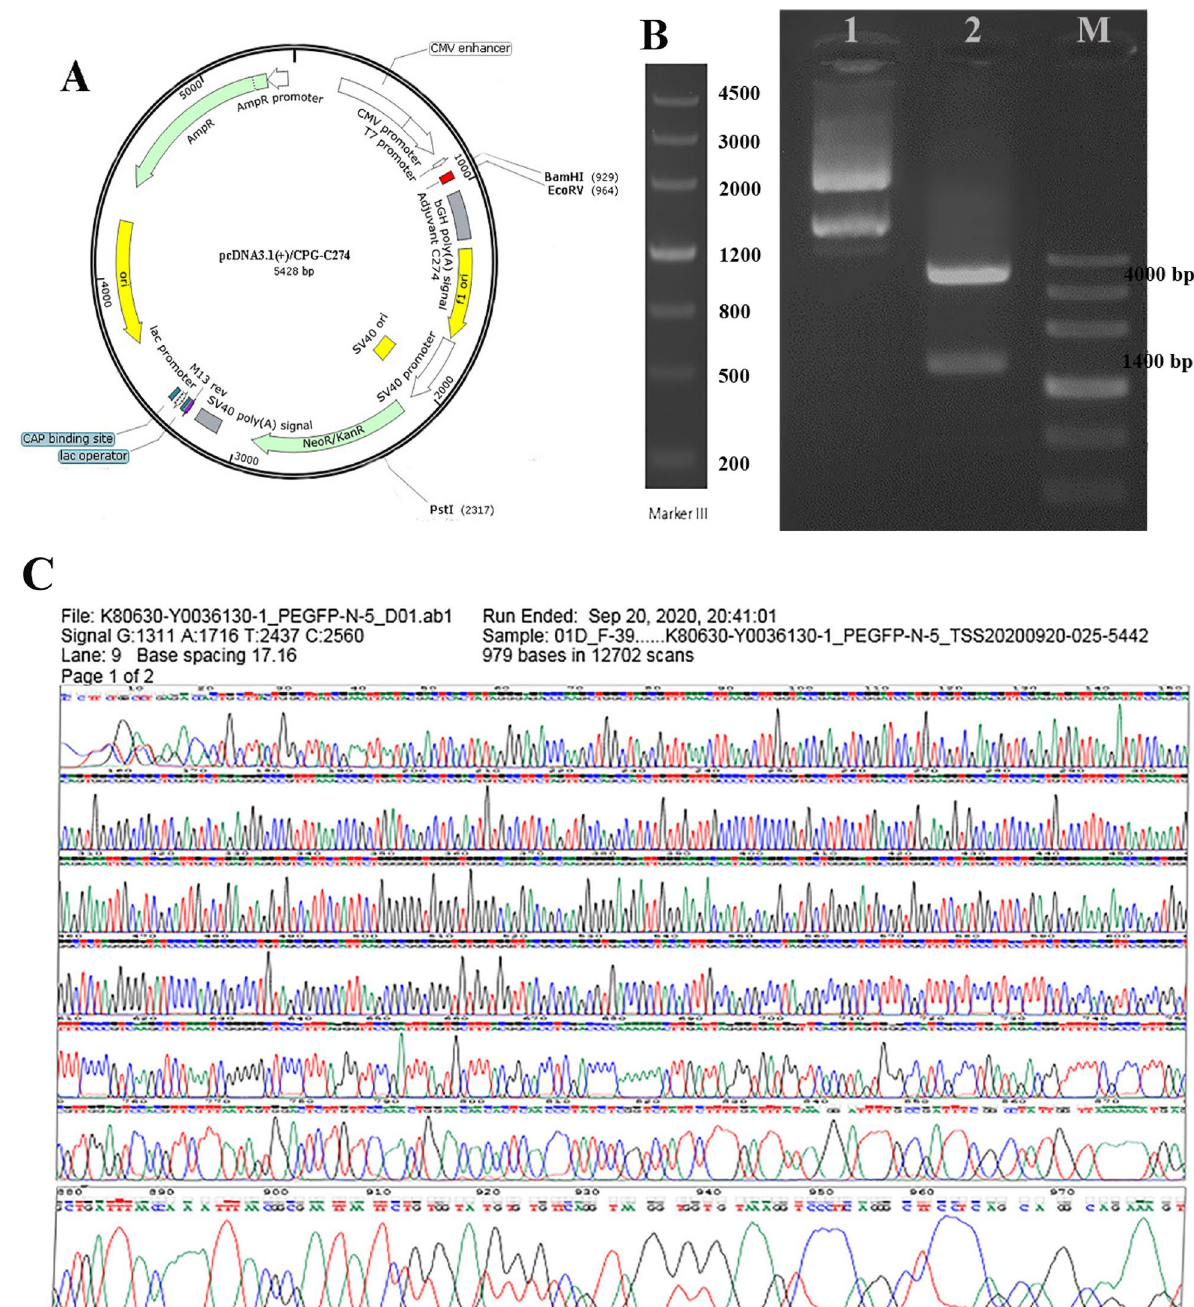
Fig. 1 Construction and identification of pDNA‑CPG C274. A Cutting sites and map of plasmid recombinant. B To separate the DNA plasmids, electrophoresis was utilized. Lane 1: pDNA‑CPG C274; Lane 2: Expected size after digestion; Lane M: DNA markerIII C The CPG sequencing from